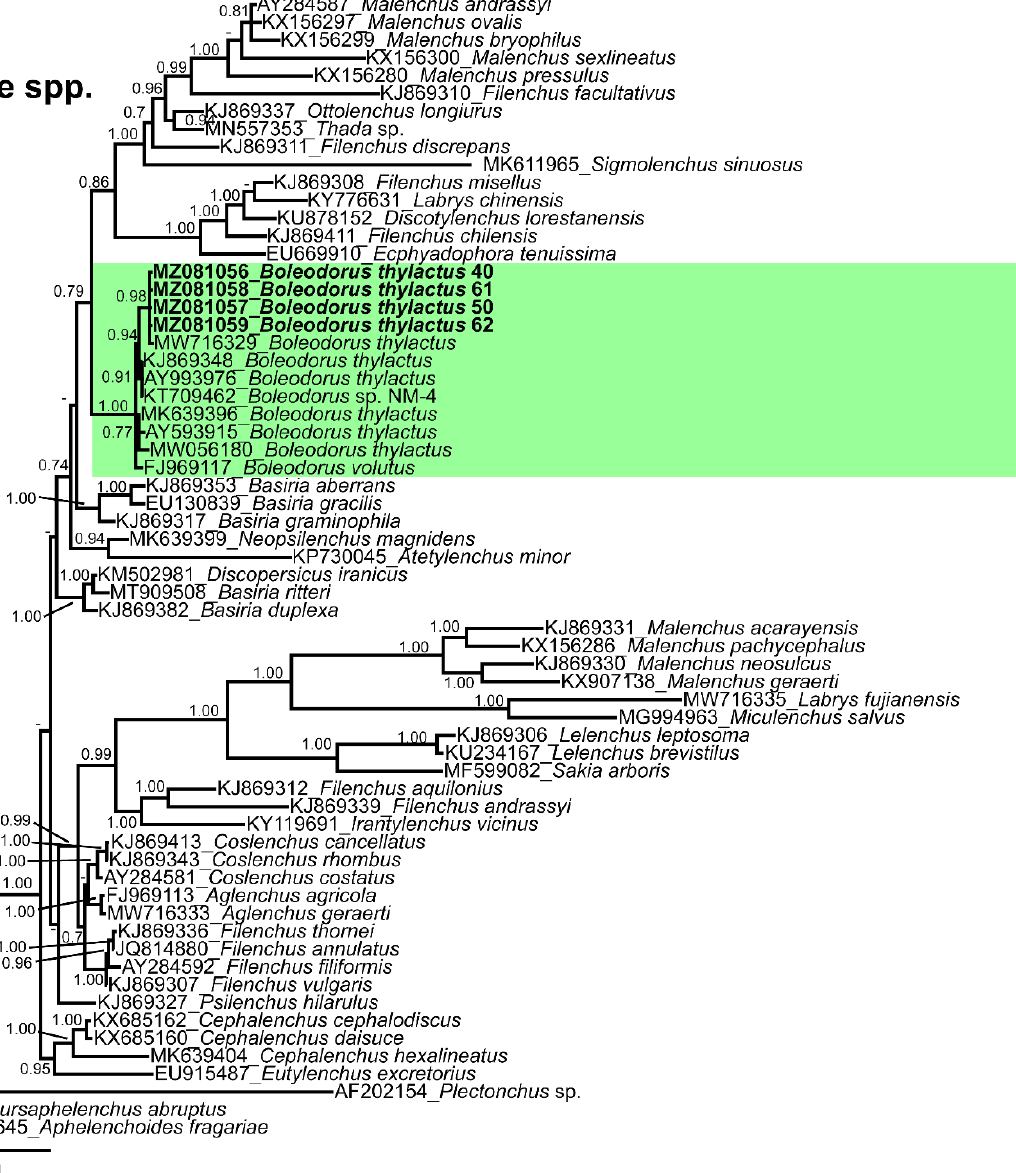
Figure 5. Phylogenetic relationships of the genus Boleodorus spp. within Tylenchidae. Bayesian 50% majority rule consensus tree as inferred from 18S rRNA gene sequence alignment under the transition model with a gamma-shaped distribution (TIM1 + G). Posterior probabilities of more than 0.70 are given for appropriate clades. Sequences newly obtained in this study are shown in bold. The scale bar indicates expected changes per site. Boleodorus spp. clade in green color.